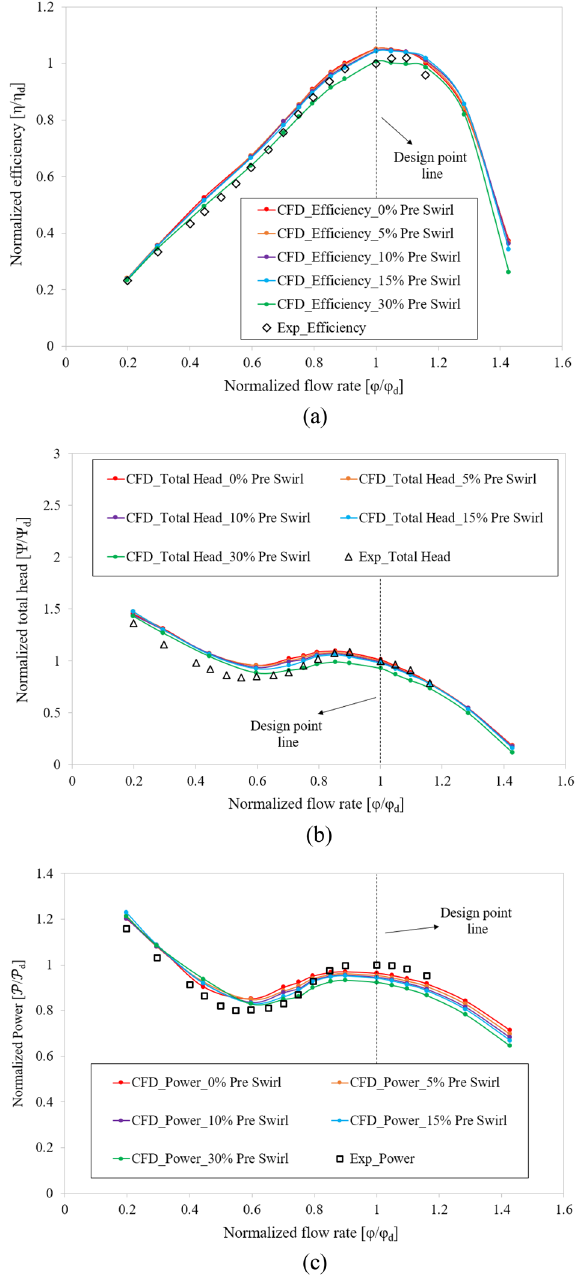
Figure 9. Comparison of hydraulic performance curves in experimental and numerical results with different pre-swirl